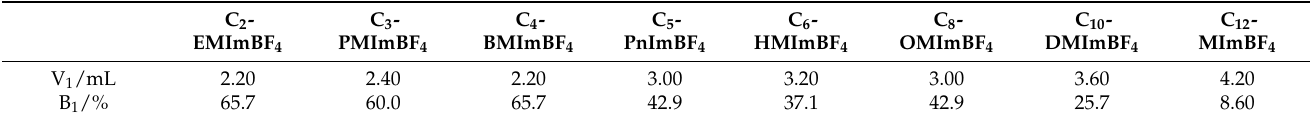
Figure 1. Anti-swelling performance of ILs (C 2 -EMImBF 4 –C 12 -MImBF 4 ) at high concentrations. Table 1. Anti-swelling rate (B 1 ) of ILs at high